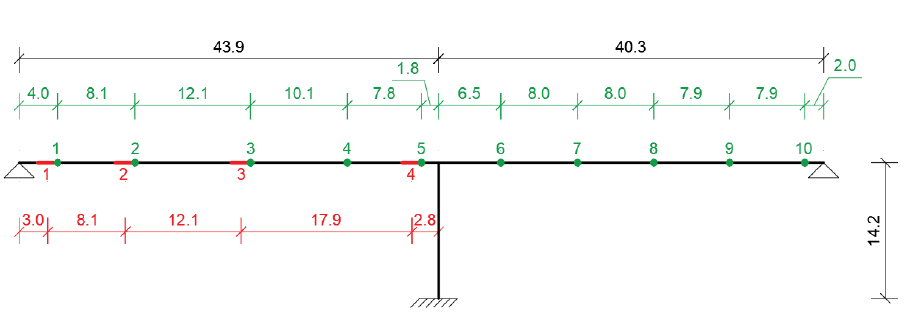
Figure 3. Overview of sensor locations indicated with green points and the damage locations indicated with red line segments. All dimensions are in